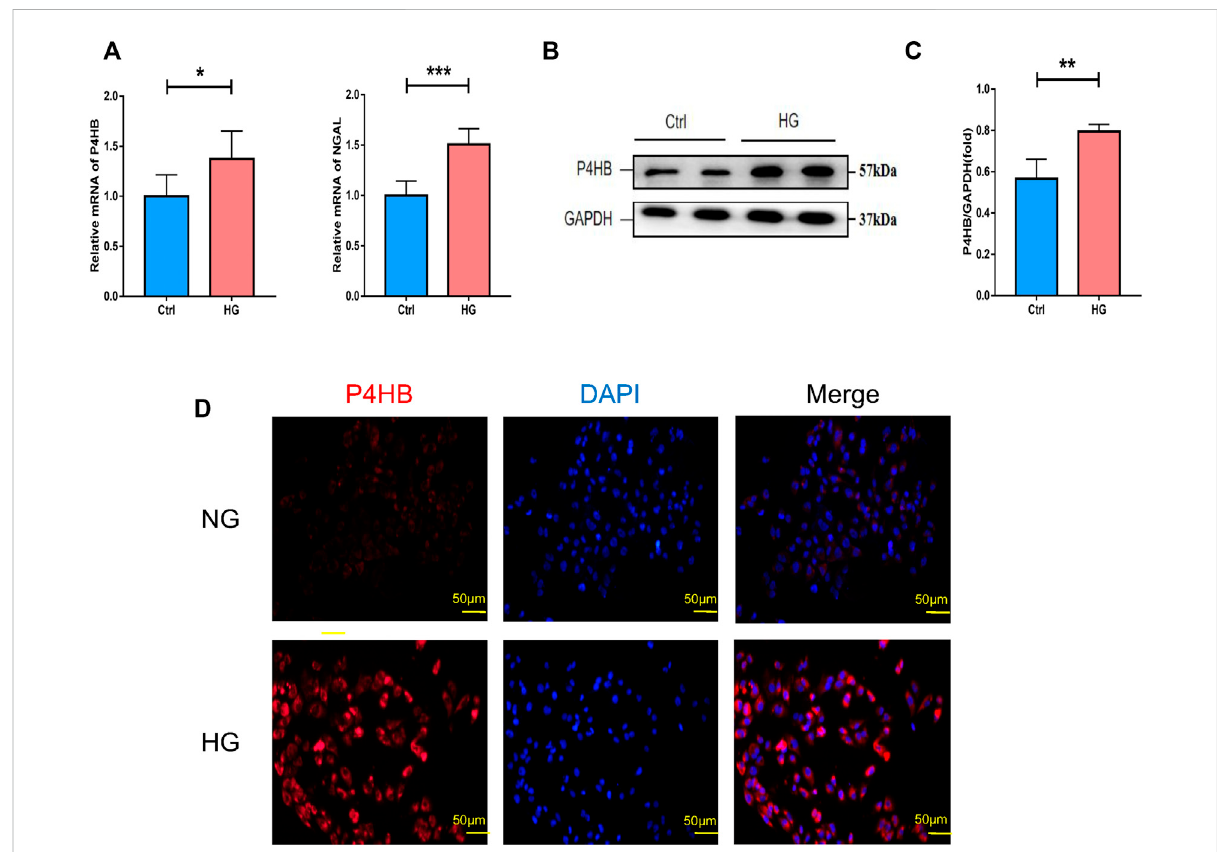
FIGURE 5 Validation of P4HB expression in vitro . (A) RT-qPCR analysis of P4HB and NGAL in HK-2 cells after HG stimulation and NG treatment. (B) Western blot analysis of P4HB in HK-2 cells after HG stimulation and NG treatment. (C) Densitometric quanti fi cation of P4HB in HK-2 cells after HG stimulation and NG treatment. Results are expressed as the mean ± SEM. * p < 0.05, ** p < 0.01, *** p < 0.001, and **** p < 0.0001. (D) Immuno fl uorescence showing the expression of P4HB in HK-2 after HG stimulation and NG treatment. Scale bars, 50 μ m. RT-qPCR,